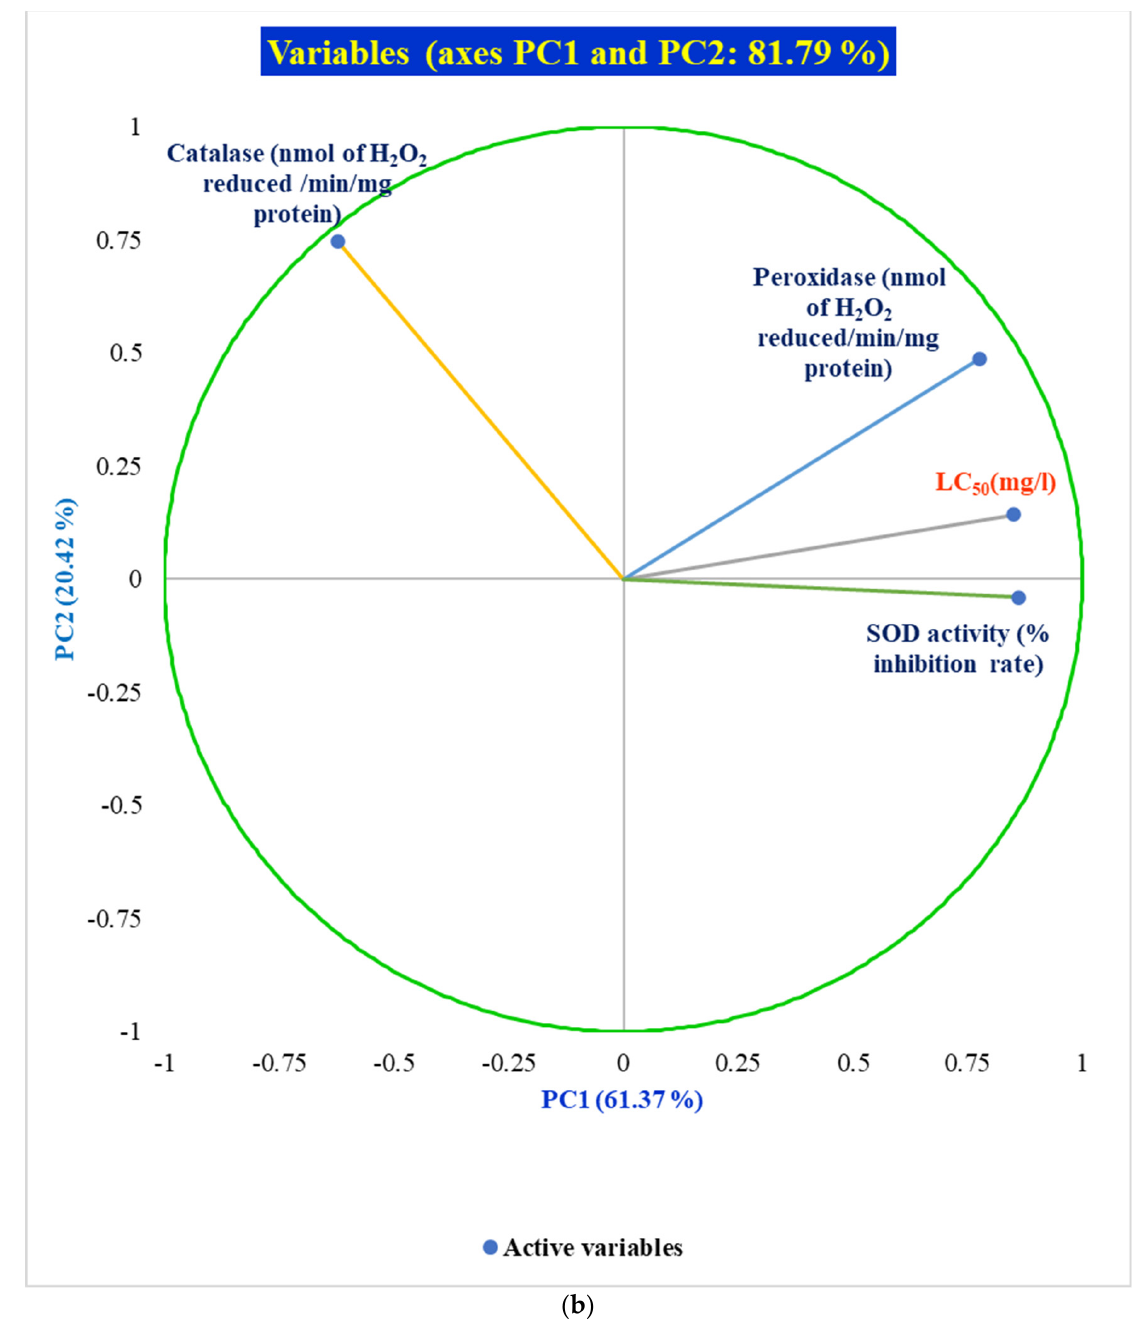
Figure 3. ( a ) Visualization of Pearson correlation showing the influence of antioxidant enzymes on the LC 50 of the populations used in this study. ( b ) Visualization of the four variables of each of the antioxidant enzymes used in this study, viz., catalase, peroxidase, SOD, and LC 50 . In the above biplot of the principal component analysis (PCA), PC1 and PC2 are represented on the horizontal and vertical axes, with a cumulative variance of 61.37% and 20.42%, respectively. The Eigenvalues of PC1 and PC2 are 2.45 and 0.82, considered as first and second factor, respectively; blue dots (•) in Figure 3. (a) and 3. (b) represent the four active variables (referring to LC 50 and each of the antioxidant enzymes, viz., catalase, peroxidase, and SOD), and orange dots (•) in Figure 3. (a) represent the 15 active observations referring to different populations in the study. The distance of the variables from the center indicates the magnitude of influence.